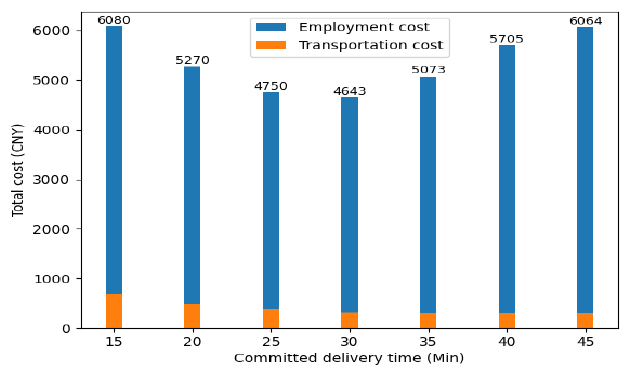
Fig. 12. The impact of the committed delivery time on the daily total